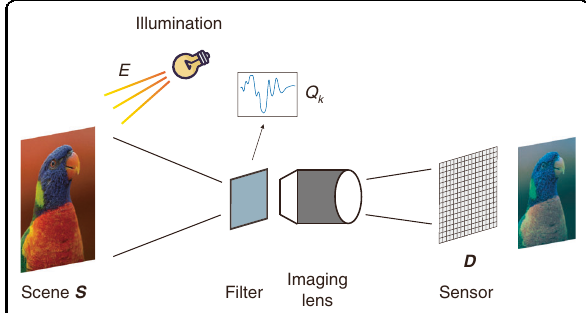
Fig. 7 Illustration of wavelength encoding spectral imaging process. The scene S is illuminated by the light source E , and is wavelength-coded through fi lters Q . Then the encoded scene spectral radiance is captured by the imaging lens on a sensor with spectral response